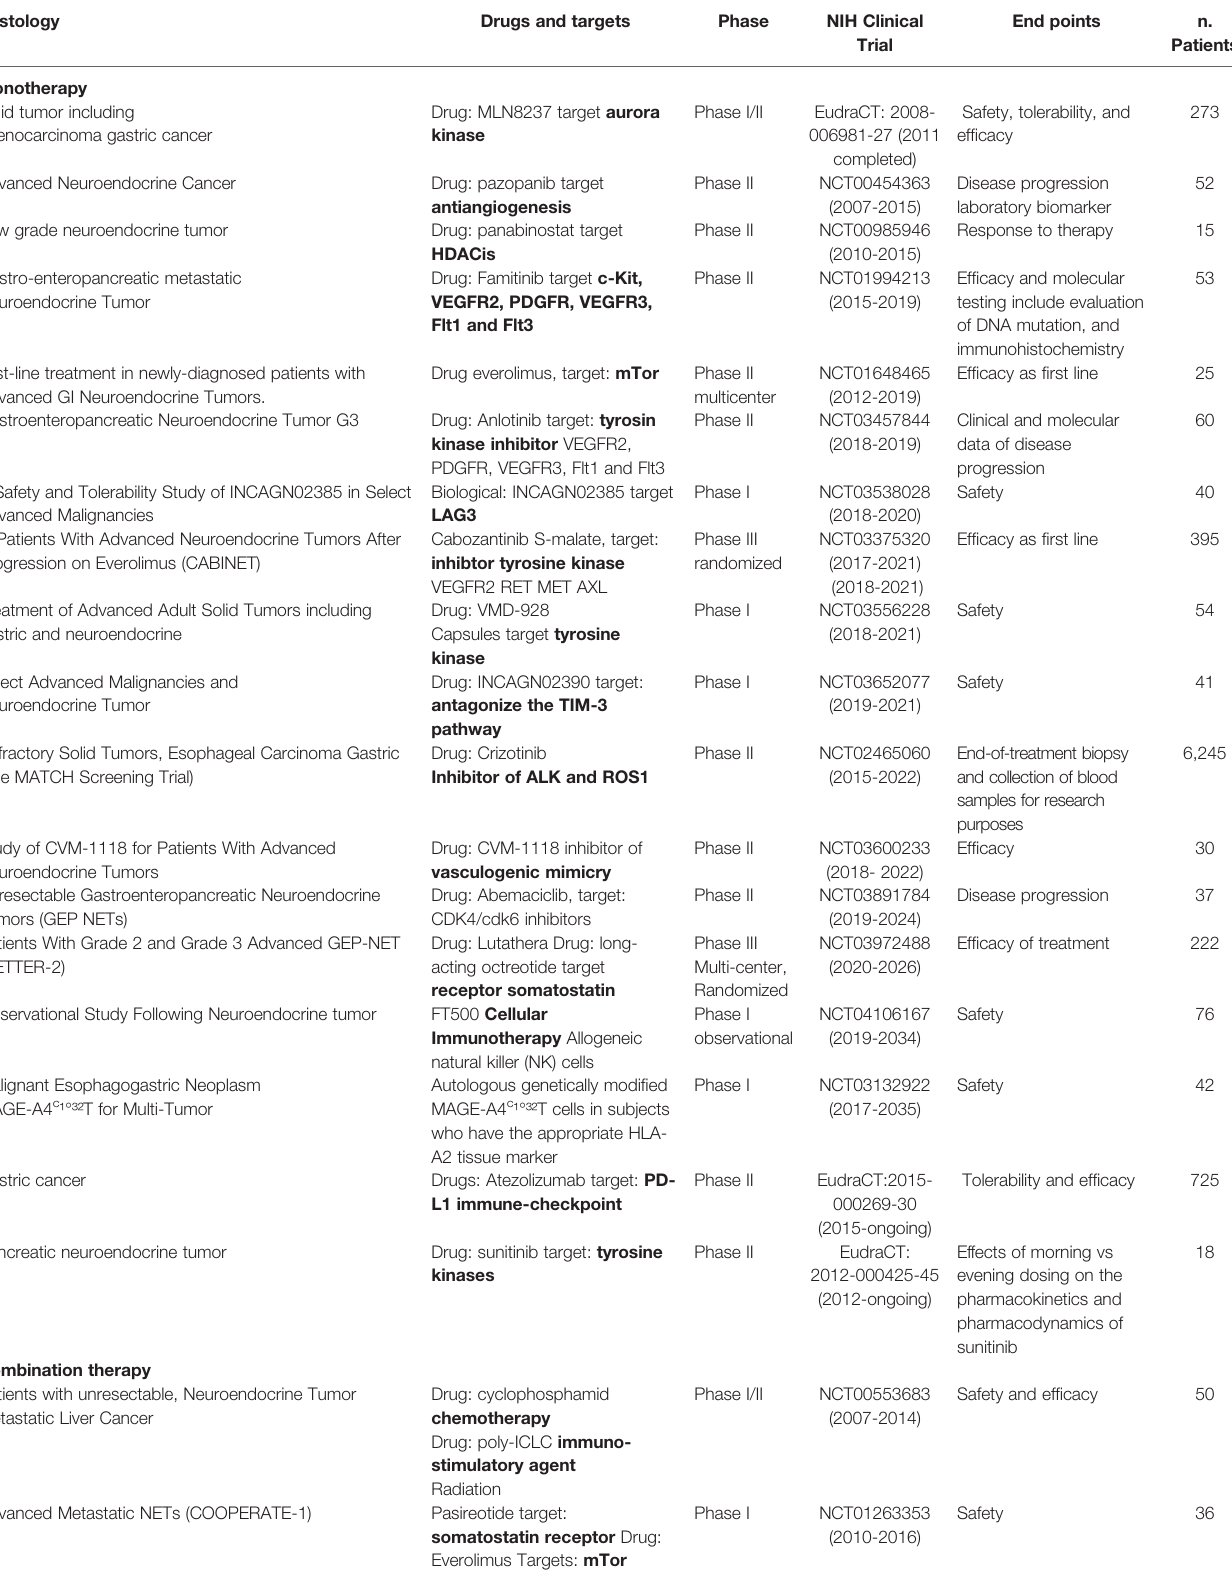
TABLE 2 | Clinical trials with drugs interfering with epigenetic